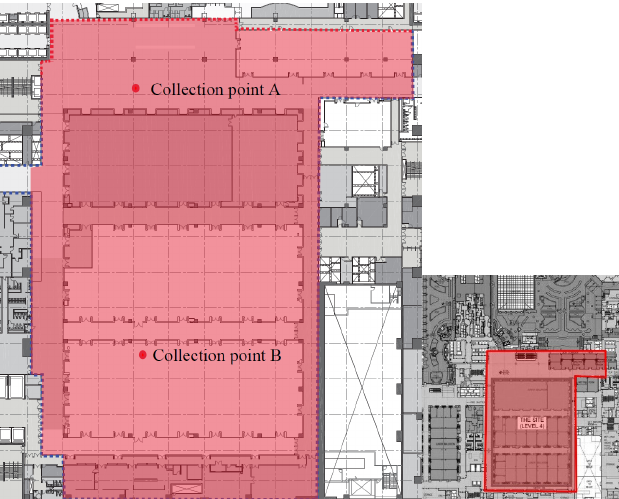
Figure 1. Layout of the construction site.